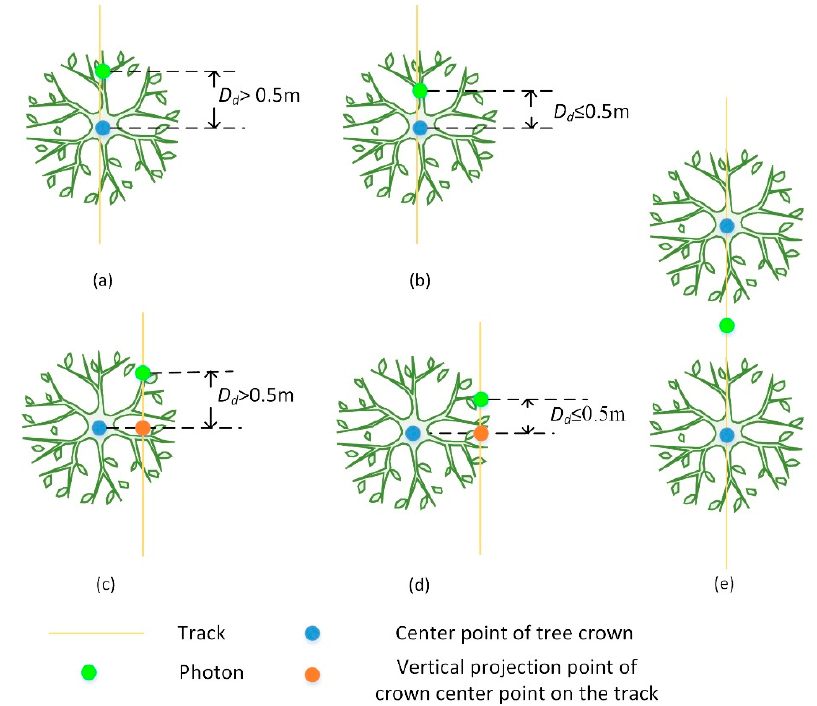
Figure 8. Schematic diagram of TOC photon correction rules: ( a ) the crown centroid and TOC photon are located in the same vertical direction and D d > 0.5 m; the TOC photon is corrected; ( b ) the crown centroid and TOC photon are located in the same vertical direction, D d < 0.5 m, and no correction is applied to the TOC photon; ( c ) the crown centroid and TOC photon are not in the same vertical direction, and the crown centroid is projected vertically to the orbit where the TOC photon is located. The TOC photon is corrected when the projection point to the TOC photon D d > 0.5 m; ( d ) the crown centroid projection point to the TOC photon D d < 0.5 m. The TOC photon is not corrected; ( e ) the TOC photons are not corrected when they are located between adjacent canopies.